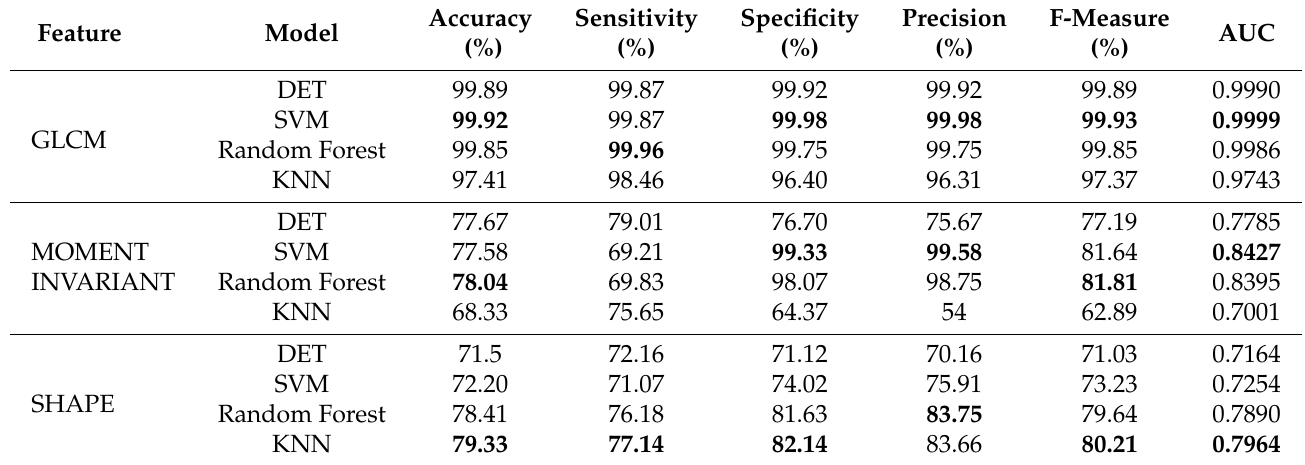
Table 3. Classification performance of four feature